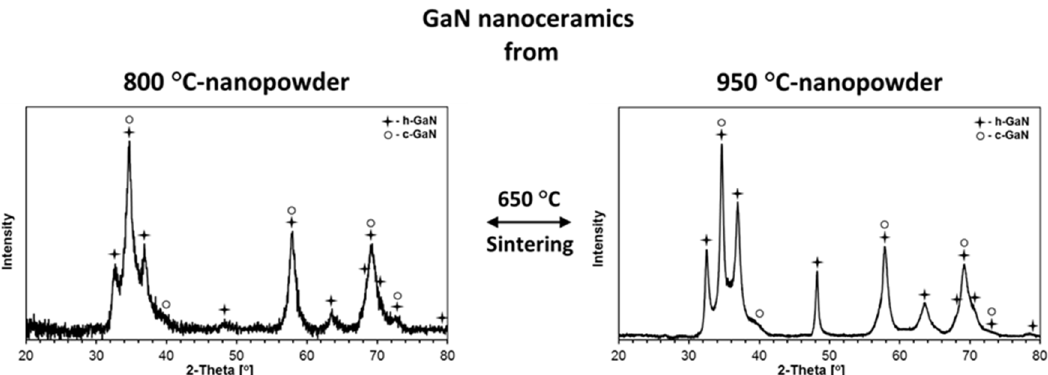
Figure 7. XRD patterns of pure GaN nanoceramics sintered from nanopowders of GaN_800 ( left ) and GaN_950 ( right ) at 650 °C, 7.7 GPa, 3 min. Table 2. XRD-derived crystallographic cell parameters a and c and average crystallite sizes D av ’s determined for composite nanoceramics in the system GaN–TiN sintered at 650, 1000, and 1200 °C and pure GaN nanoceramics sintered at 650 and 1000 °C. Note that relevant cases of individual TiN nanoceramics are included in [32].